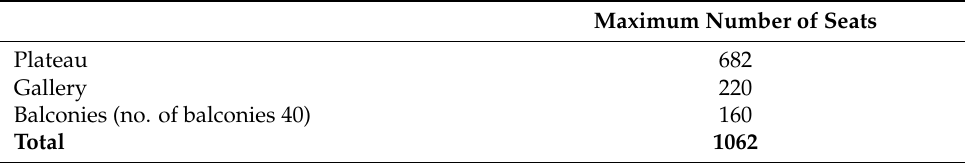
Table 1. Maximum capacity of the large, horseshoe-shaped hall.